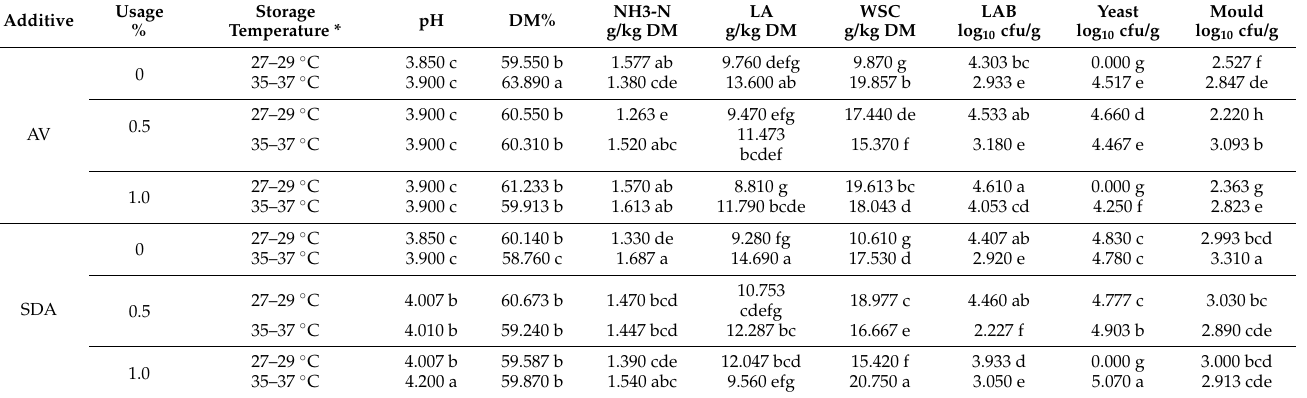
Table 2. Effects of additives and storage conditions on the second day of aerobic stability of high moisture maize